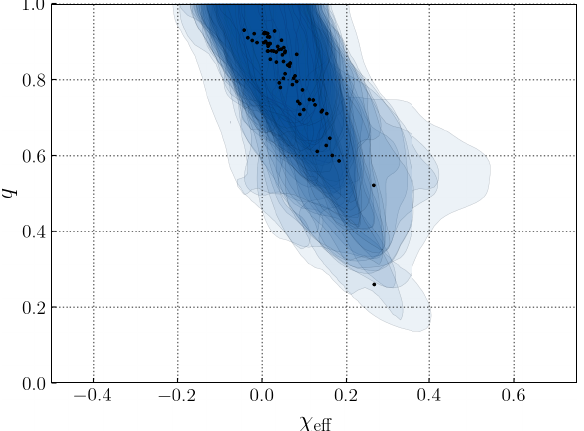
FIG. 21. Posteriors on the mass ratios and effective inspiral spins of BBHs in GWTC-3, reweighted to a population-informed prior allowing for a correlation between q and χ . We infer that eff the mean of the BBH χ distribution shifts toward larger values eff with decreasing mass ratios. Accordingly, reweighted events shift ≈ 0 considerably, such that events with q ∼ 1 contract about χ eff while events with q < 1 shift toward larger effective inspiral FIG. 20. Posterior constraints on the mean (top) and standard deviation (bottom) of the χ distribution as a function of mass eff ratio q . At 97.5% credibility, we find that the mean of the χ eff shifts toward larger values for more unequal-mass systems. The gray region in the lower panel shows the area artificially excluded by our prior on the parameters σ 0 and β ; see Eq. (20).